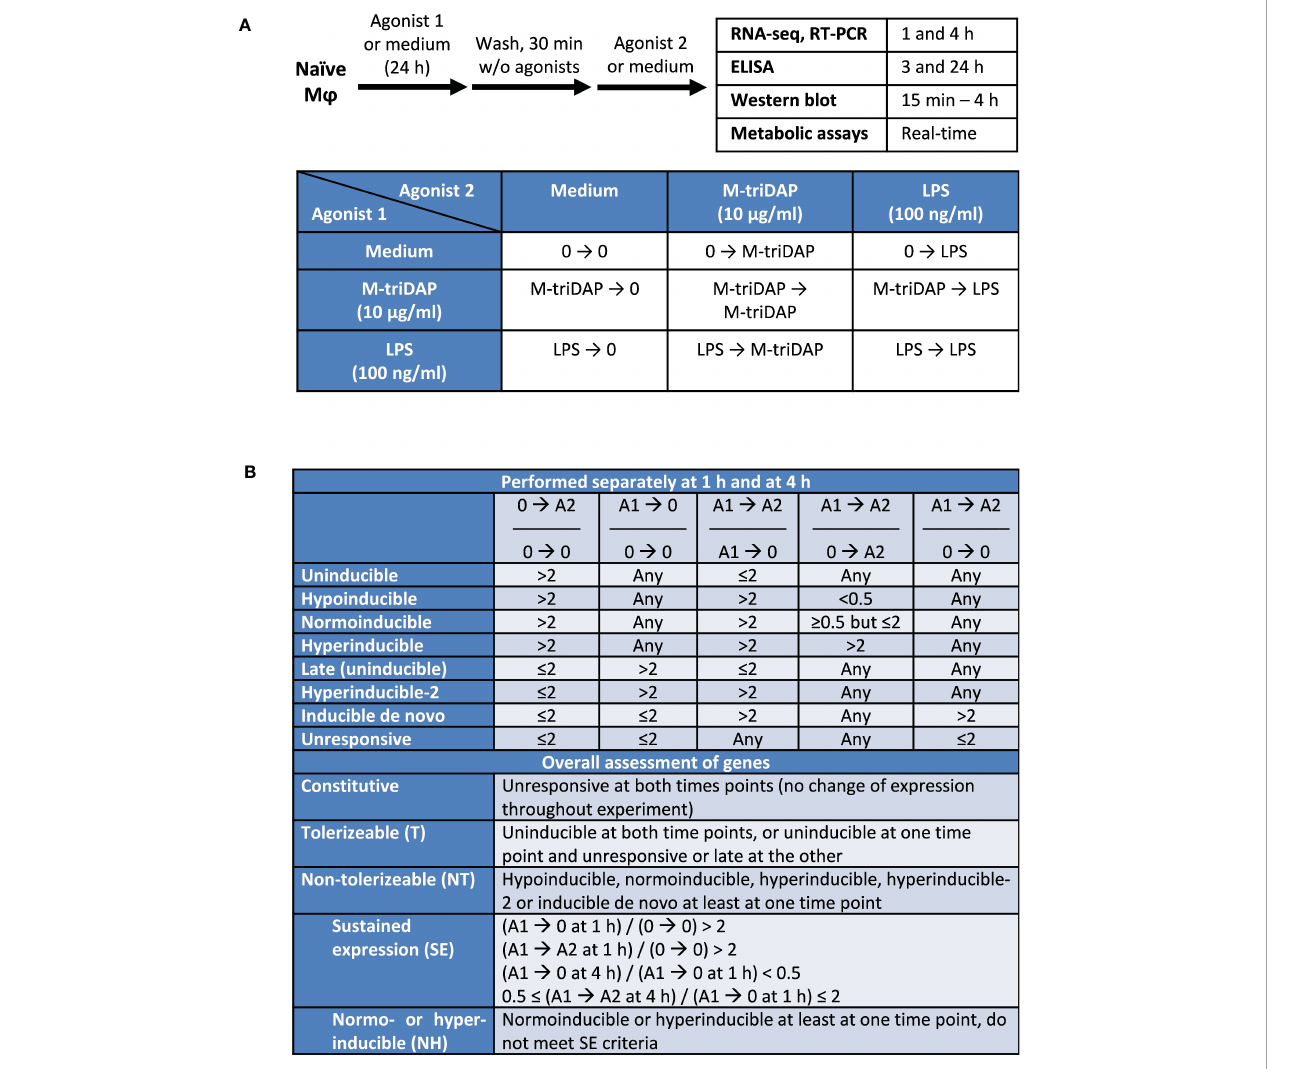
FIGURE 1 Experimental design of the study and criteria of gene classi fi cation. (A) Design of cell culture experiments. (B) Criteria of gene classi fi cation based on ratios of RPM. Agonist 1 (A1) is the one used for the 1 st stimulation (24 h), agonist 2 (A2) for the 2 nd stimulation (1 or 4 h). Agonists 1 and 2 can be the same. 0, culture without